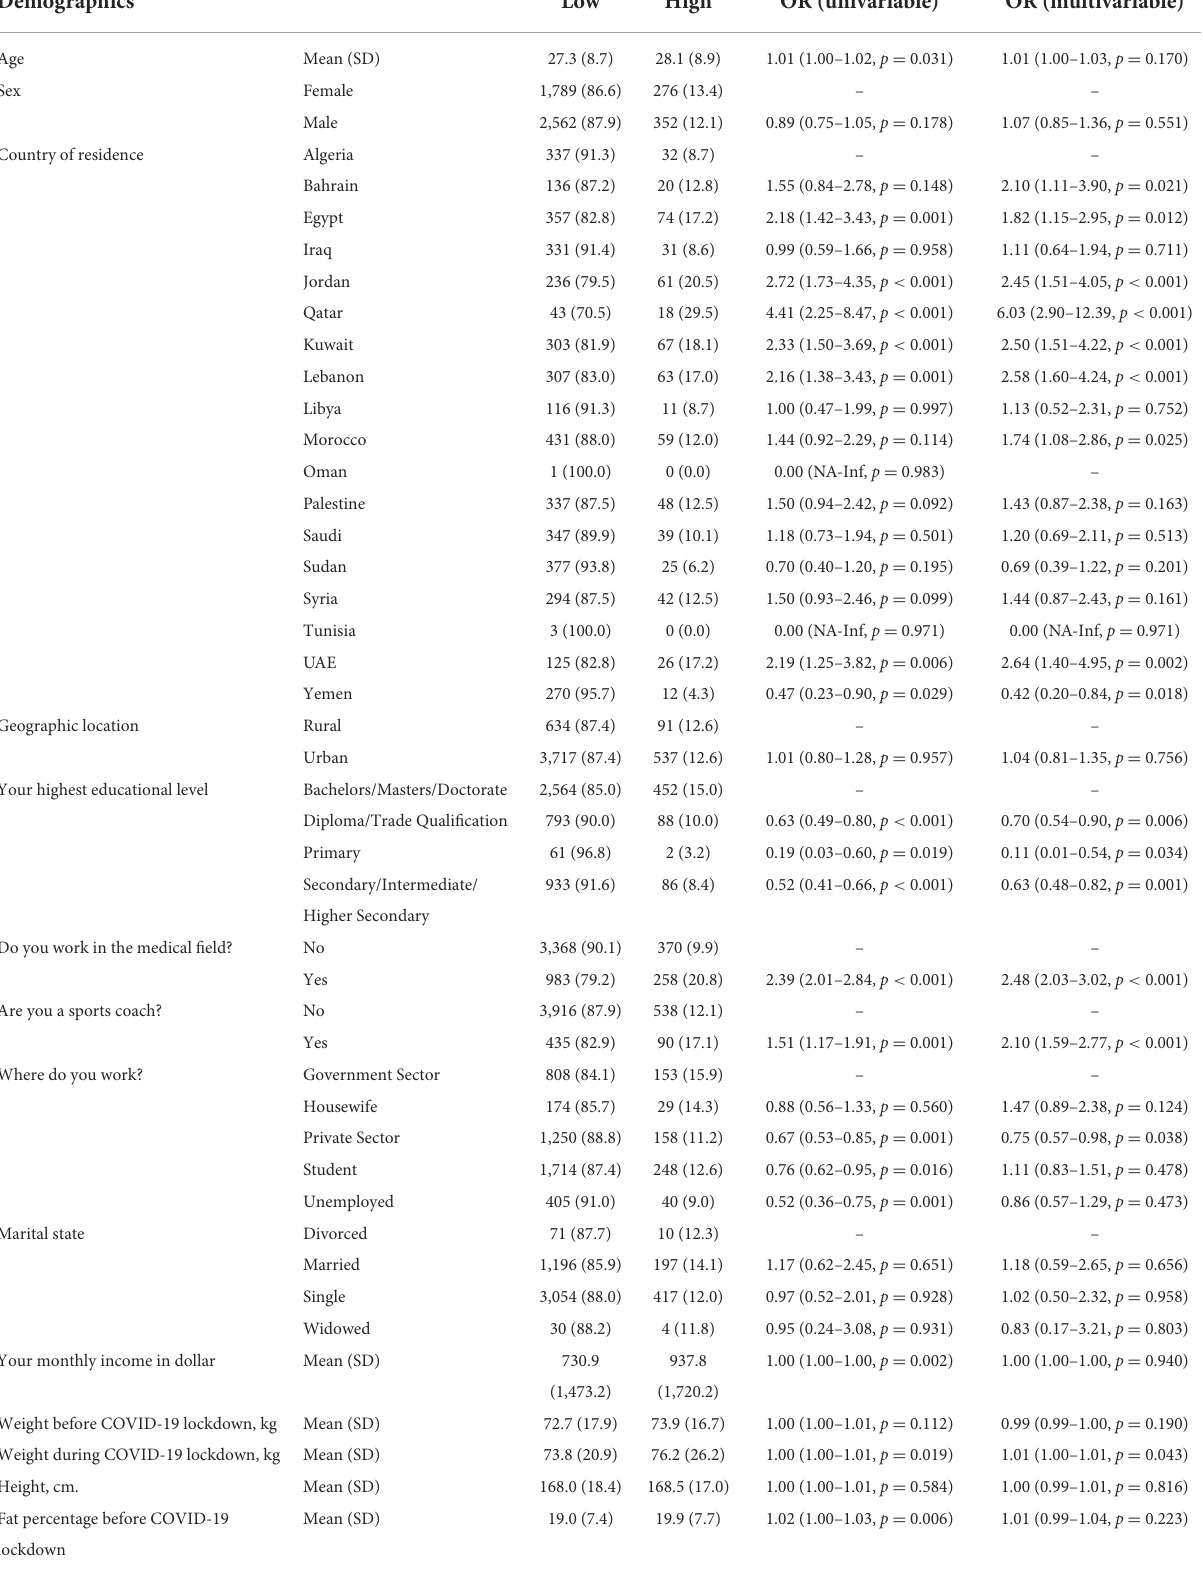
TABLE 5 Logistic regression models for the association between demographics and high level of